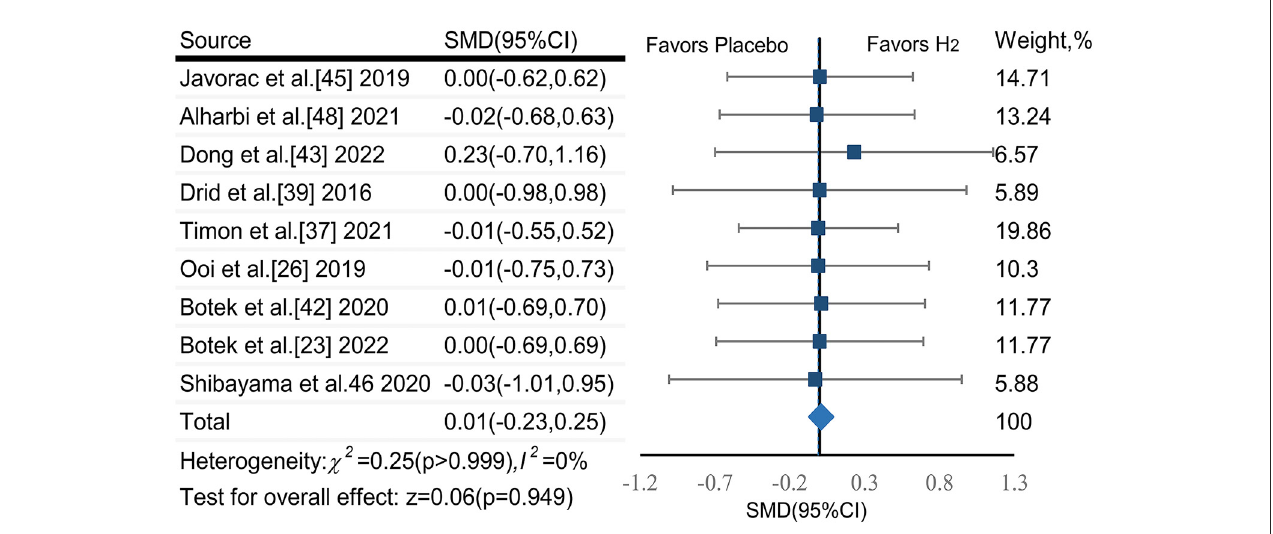
FIGURE6 The pooled effect size of H 2 intake on endurance